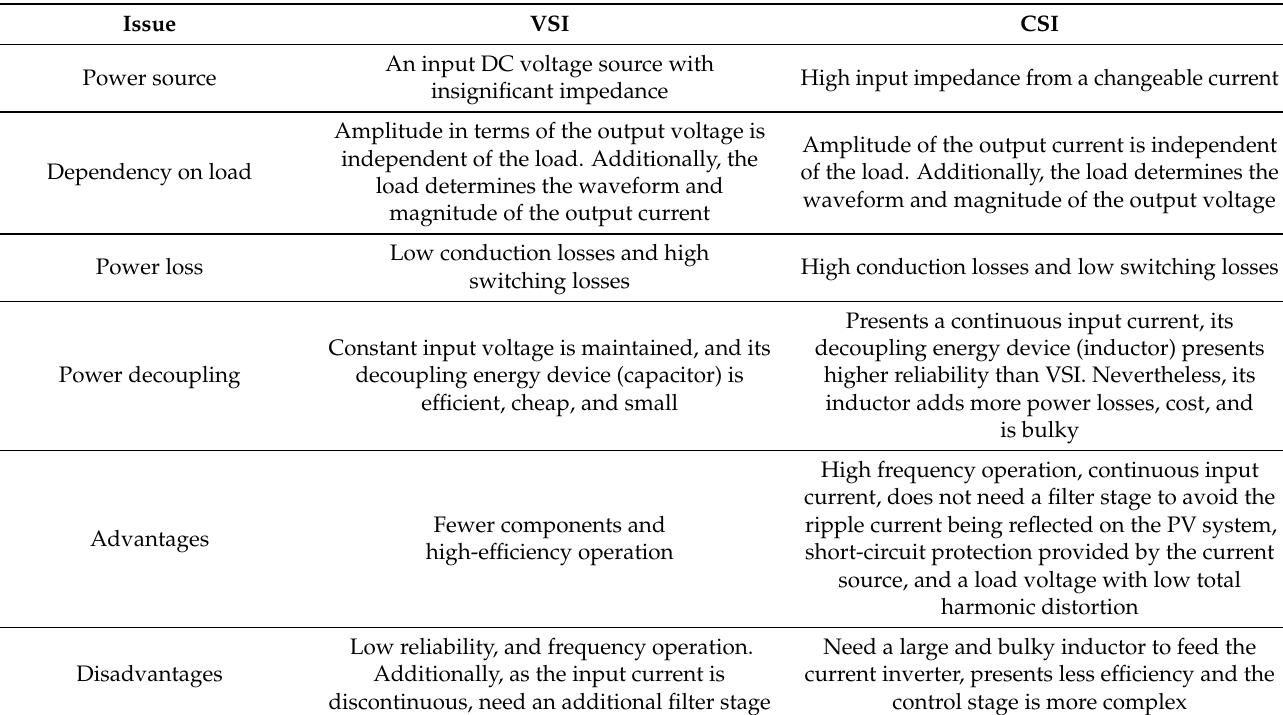
Table 8. Differences between VSI and CSI [117–126].